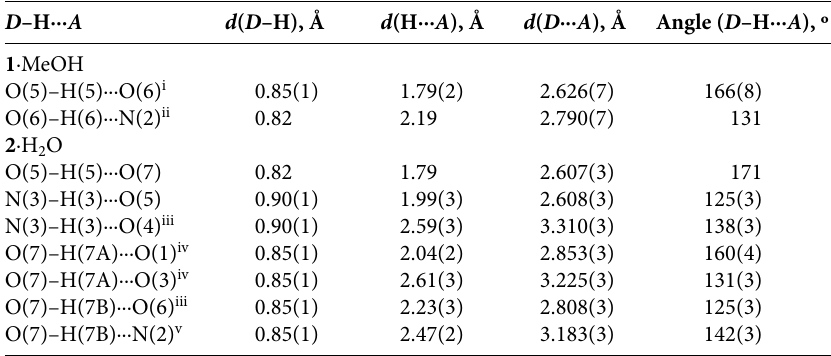
Table 3. Hydrogen bond distances (Å) and bond angles (°) for the